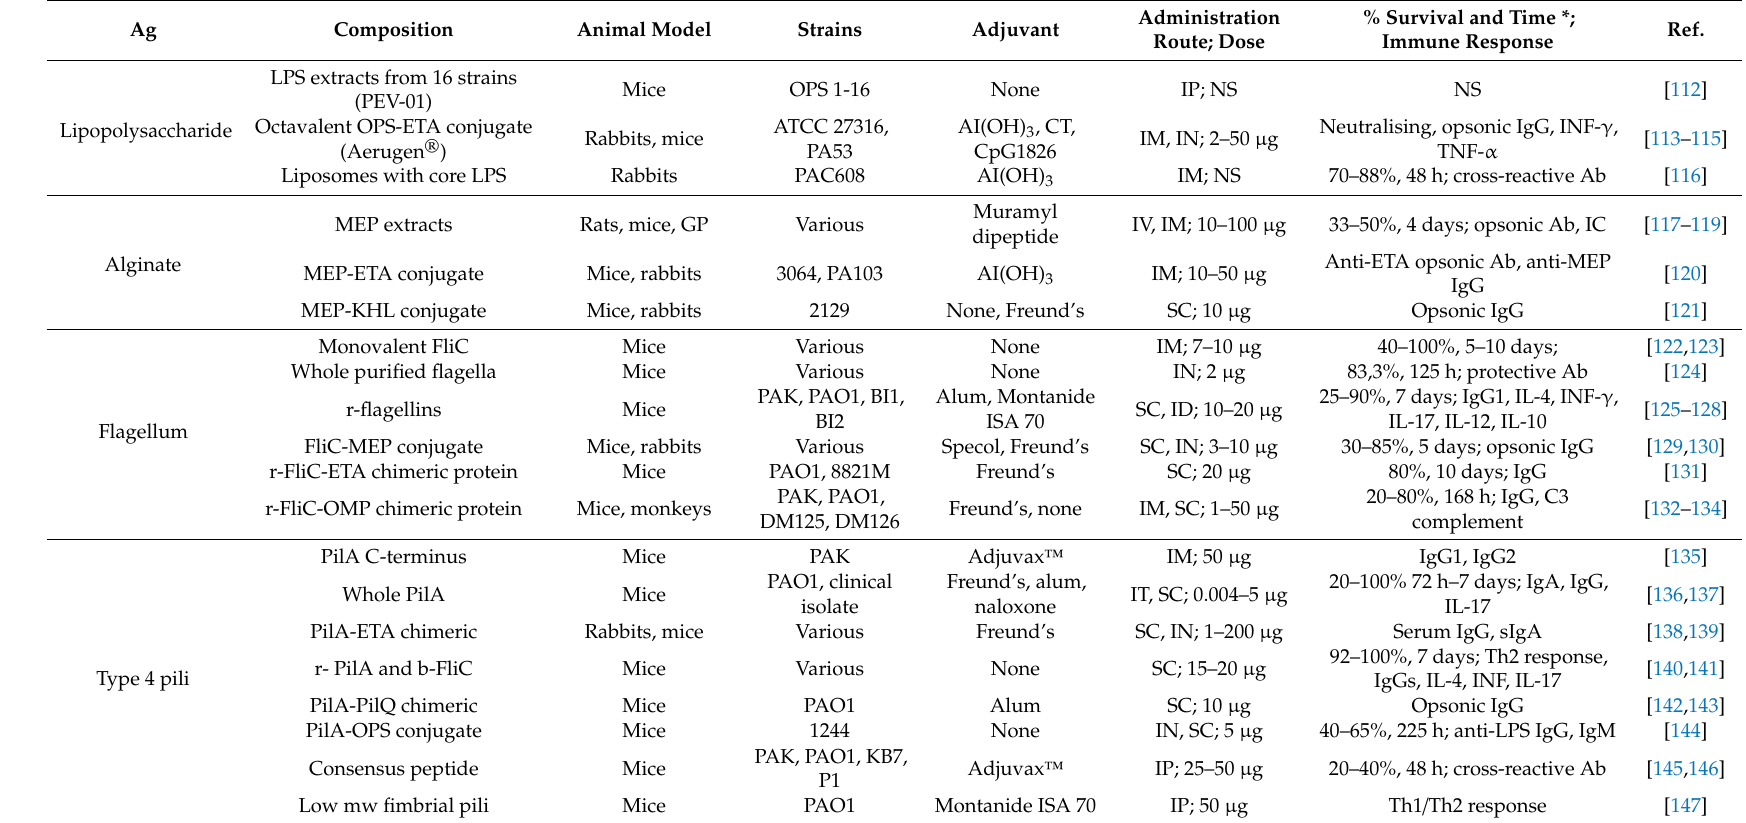
Table 1. Summary of pre-clinical studies on P. aeruginosa vaccine candidates